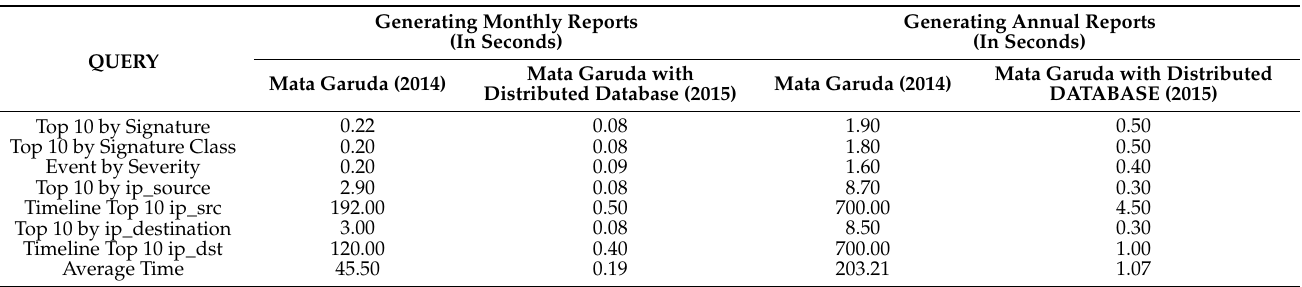
Table 1. Mata Garuda with distributed database (2015) significantly improves the computation time needed to generate reports compared to the Mata Garuda (2014).